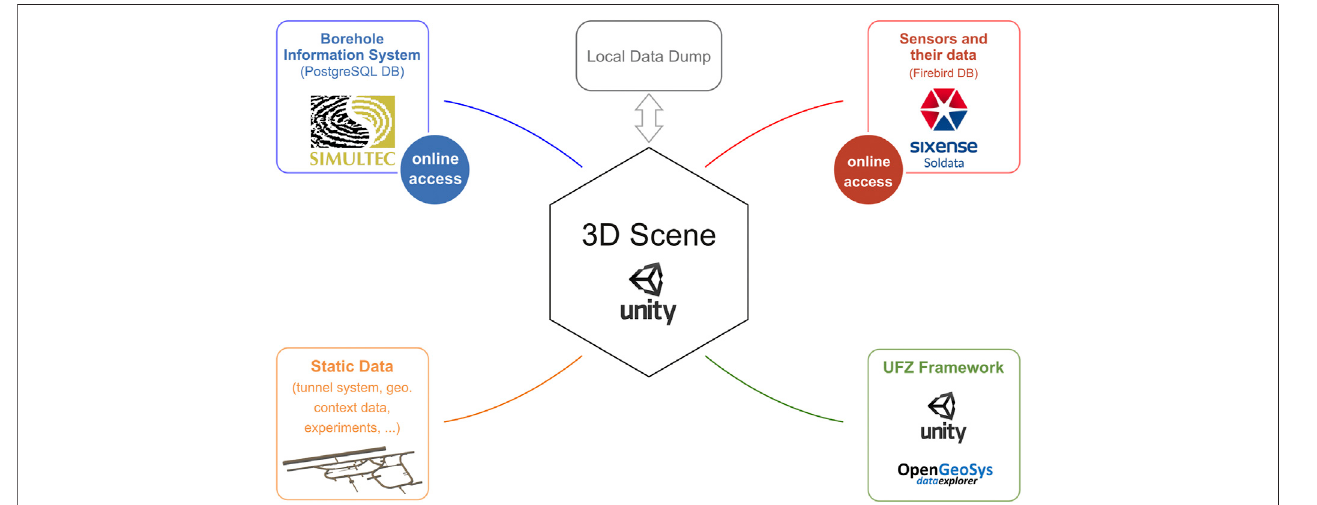
FIGURE 1 | Overview of the integrated data sources. The copyright of the logos belong to the corresponding